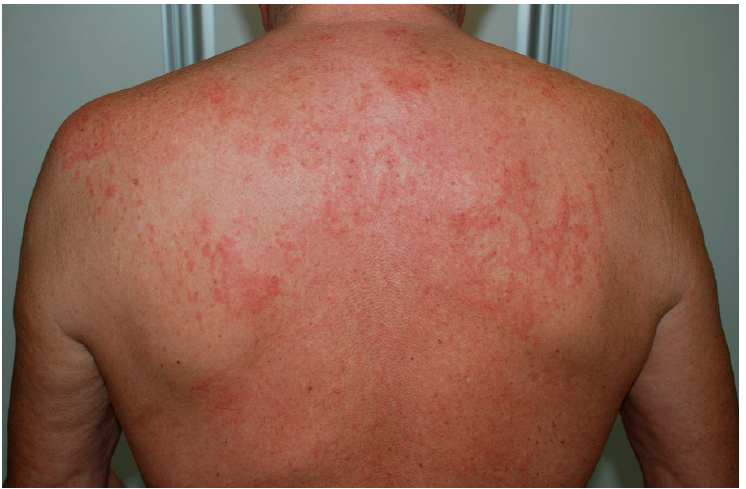
Figure 1. Wheal-and-flare papules and plaques on the back due to urticarial vasculitis. The urticaria-like lesions are usually dark-red or brown, especially in the